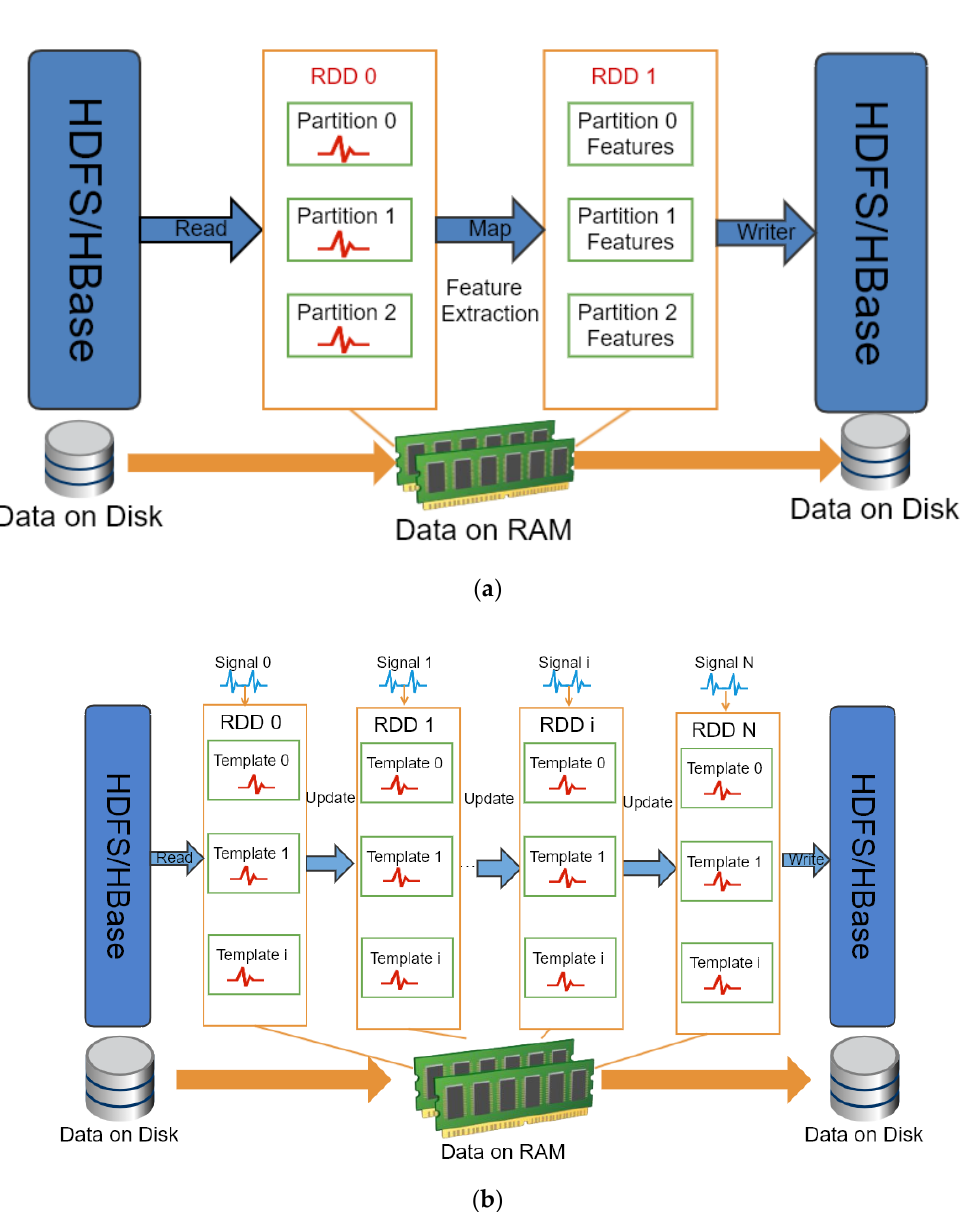
Figure 6. Paralleled extraction and classification of plant electrical signals based on Spark ( a ) Feature